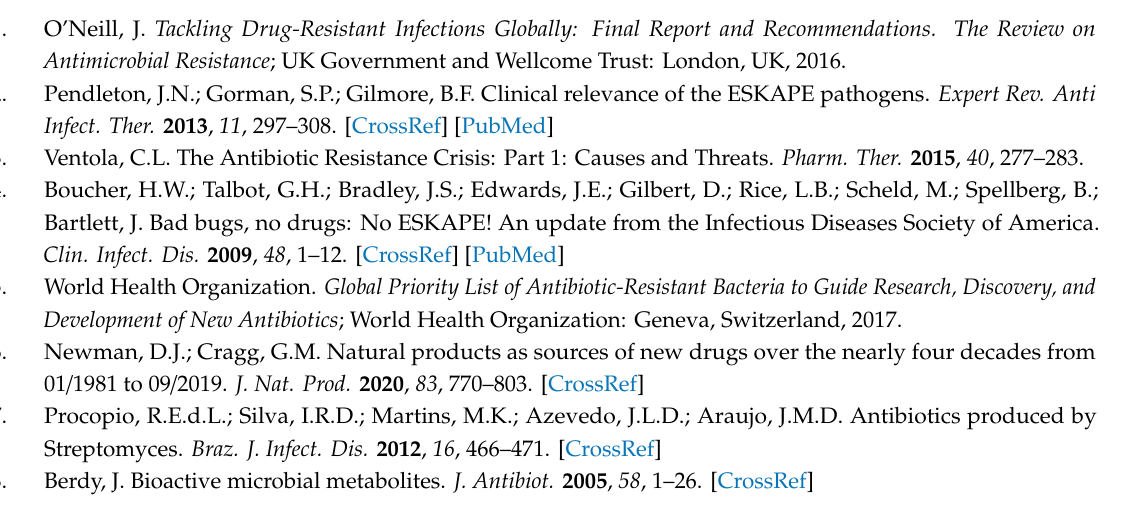
Figure S1: Time-kill curves of K. pneumoniae DSM-30104 exposed to CHD (MIC: 1 µ g / mL) and CDCHD (MIC: 0.5 µ g / mL) at 0.5- and 2-fold MIC. Cell viability was determined over 24 h by three independent CFU (colony forming units) counts. Data are represented as mean values ± standard deviation, Figure S2: Growth curves of K. pneumoniae DSM-30104 wild type and CHD-resistant mutants (Mt8.1–Mt8.10) over 24 h. Data represent OD 600 values at each time point. The nine mutant strains were cultivated in presence of 8 µ g / mL CHD ( = 8-fold MIC), Table S1: MIC values of CHD, CDCHD and tetracycline (TET) for Gram-positive and Gram-negative bacteria (non-clinical strains). a multidrug-resistant S. aureus ; b methicillin-83 resistant S. aureus ; c vancomycin-intermediate S. aureus ; n.d.: not determined, Table S2: Minimal inhibitory concentrations (MICs) and minimum bactericidal concentrations (MBCs) of CHD and CDCHD for E. coli and K. pneumoniae clinical isolates determined in artificial urine at di ff erent pH values. Values denote median of three independent measurements per isolate, Table S3: Susceptibility of K. pneumoniae DSM-30104 wild type (Wt) and K. pneumoniae CHD-resistant mutants (Mt8.1–Mt8.10) to various antibiotics, Table S4: Mutations identified in K. pneumoniae DSM-30104 CHD-resistant mutants (Mt8.1–Mt8.10) by whole genome sequencing. bp: base pair; Ins: insertion; ∆ : deletion; #: number of a ff ected bp; RE: repeat expansion. Change of codon function indicated by respective amino acids (in one letter code), Table S5: Relative transcription levels of ramA , acrA and acrB genes of K. pneumoniae CHD-resistant mutants in comparison to K. pneumoniae DSM-30104 wild type (analyzed by qPCR). n.d.: not determined, Table S6: Activity of K. pneumoniae DSM-30104 wild type and CHD-resistant mutants in the presence of phenylalanine arginine β -naphthylamide dihydrochloride (PA β N). TET: tetracycline; TIG: tigecycline; CM: chloramphenicol; CIP: ciprofloxacin, Table S7: MIC values of CHD-resistant mutants (selected strains C2087–C2100) developed from A. sulphurea ∆ chdPKS ∆ chdAR (parent strain); determined in TSB medium, Table S8: Mutations identified in A. sulphurea ∆ chdPKS ∆ chdAR CHD-resistant mutants (strains C2087–C2100, see Table S7) by whole genome sequencing. Change of codon function indicated by codon number and respective amino acids (in one letter code), Table S9: Primers for K. pneumoniae ramR and A. sulphurea chdAR gene deletions and vector constructs, Table S10: Primers used for